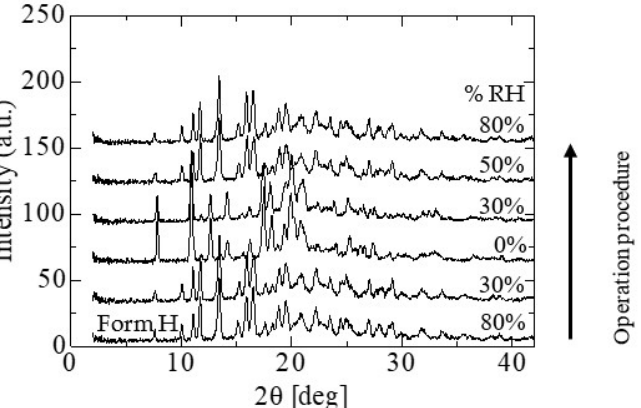
Figure 7. Reversible transition between Form H and Form H-1 shown in PXRD patterns. XRD patterns: (the bottom) the original Form H, (the third from the bottom) Form H-1 at zero % RH, and (the top) the restored Form H.